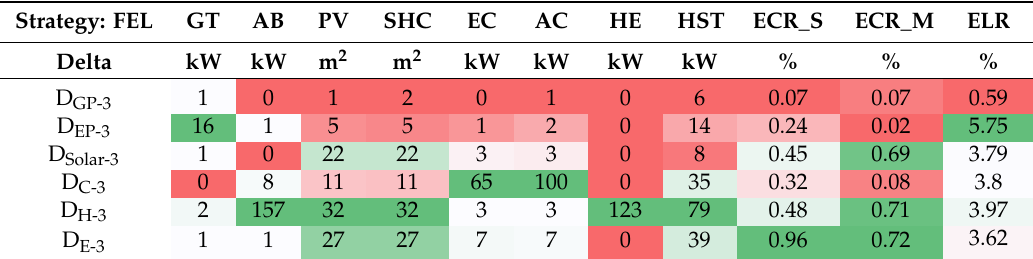
Table 10. The absolute deviation of optimal design between the single uncertain cases and case 3. Strategy: FEL